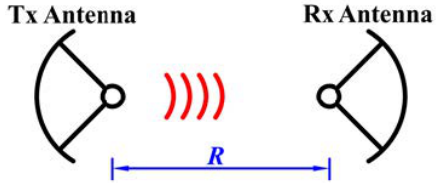
Figure 1. The schematic diagram of the communication system.